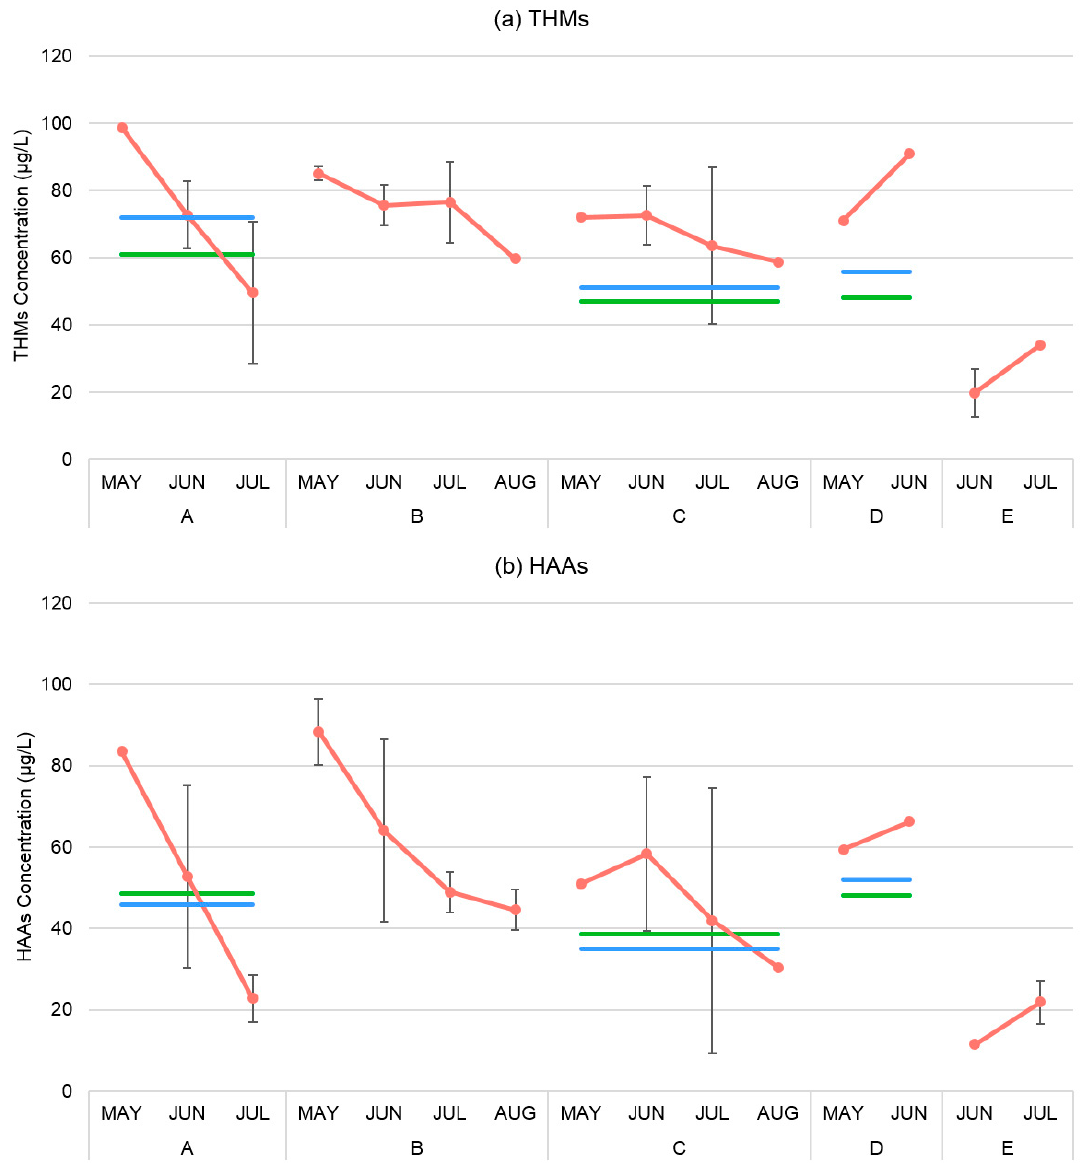
Figure 2. Temporal comparison of monitored ( a ) total THMs and ( b ) HAAs levels with LRAA compliance and QA data.